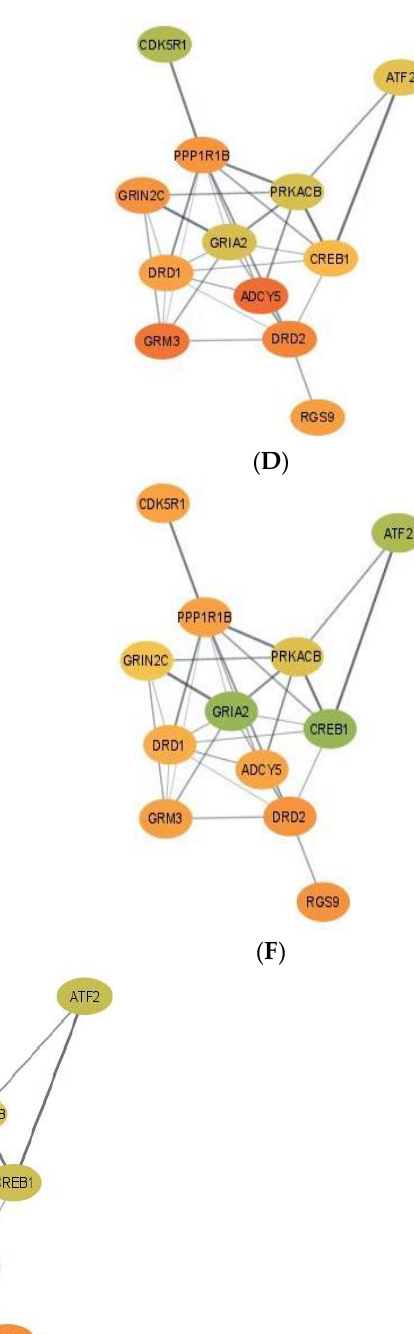
Figure 2. Gene networks for the cocaine addiction pathway in the hippocampus developed using Cytoscape and the STRING database. Nodes represent genes and edges represent database connec- tions. The node color ranges from red that signifies a − 2.0 log2 (fold change), yellow indicates no fold change, and green indicates a 2.0 log2 (fold change), with colors in between indicating a spec- trum. Changes correspond to seven pig groups compared to the baseline Control nursed males. The seven pig groups are: ( A ) — Control nursed females, ( B ) — MIA nursed females, ( C ) — Control weaned females, ( D ) — MIA weaned females, ( E ) — MIA nursed males, ( F ) — Control weaned males, and ( G ) — MIA weaned males compared to Control nursed males.